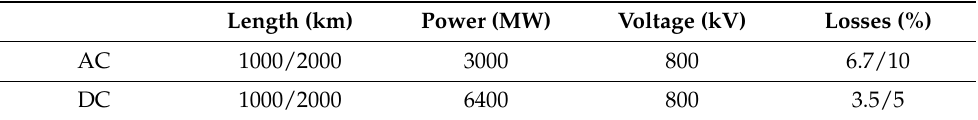
Table 1. Comparison of HVAC and HVDC power transmission cables [58].